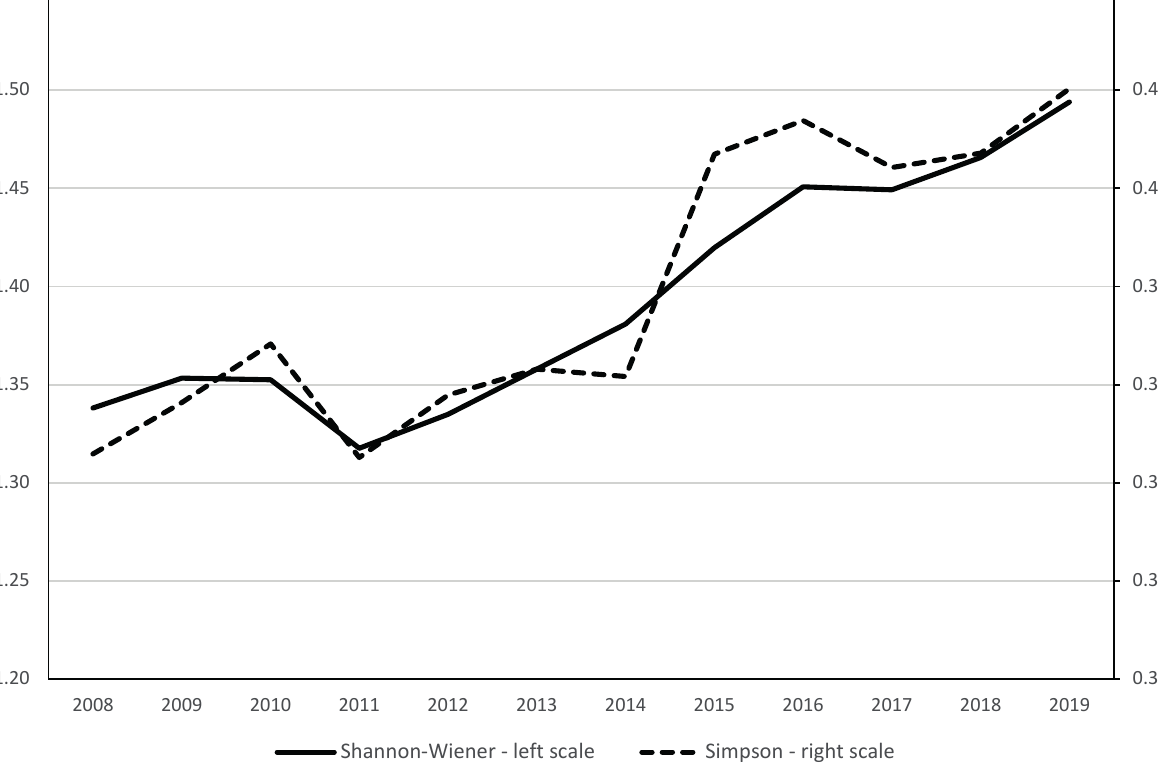
Figure 12. Evolution of the average Shannon and Simpson diversity indexes within the Italian 2008-2019 FADN balanced